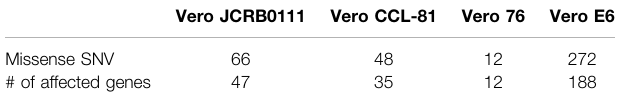
TABLE 1 | Subline-speci fi c/enriched missense variants.